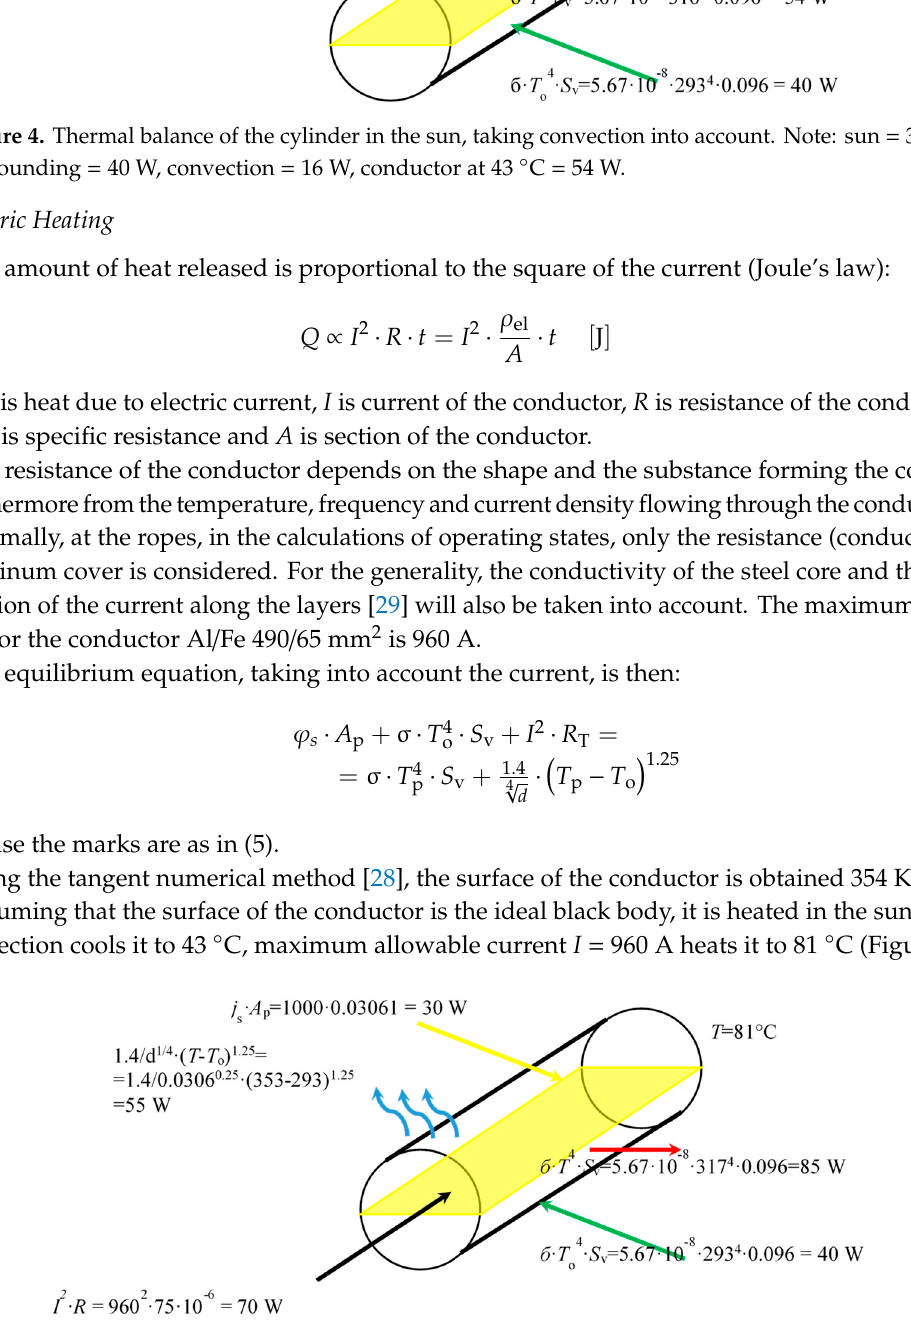
Figure 5. The heat balance of the conductor in the sun, taking into account electrical heating and convection. Note: sun = 30 W, surrounding = 40 W, Joule’s heating = 70 W, convection = 55 W, conductor at 43 °C = 54 W.